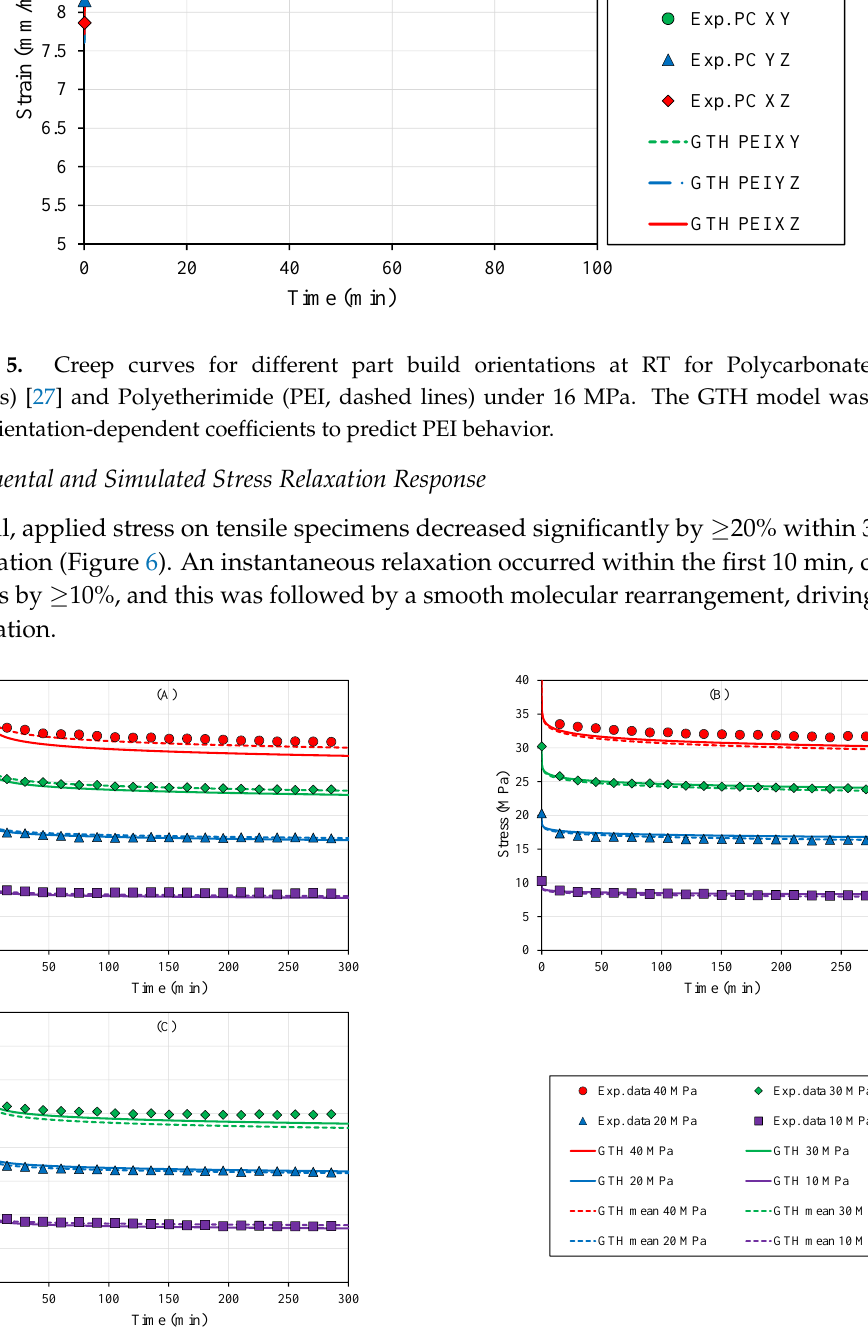
Figure 6. Stress relaxation curves for different part build orientations at RT: ( A ) XY, ( B ) YZ, and ( C ) XZ. The XZ orientation’s specimens broke during the initial loading to 40 MPa. The GTH coefficients fitted to each orientation (solid lines) were able to predict stress relaxation behavior in all orientations (XY: r = 0.998, p < 0.001; YZ: r = 0.999, p < 0.001; XZ: r = 0.998, p < 0.001), although the averaged GTH coefficients (dashed lines) provided a better predictive performance (XY: r = 0.999, p < 0.001; YZ: r = 0.999, p < 0.001; XZ: r = 0.998, p <